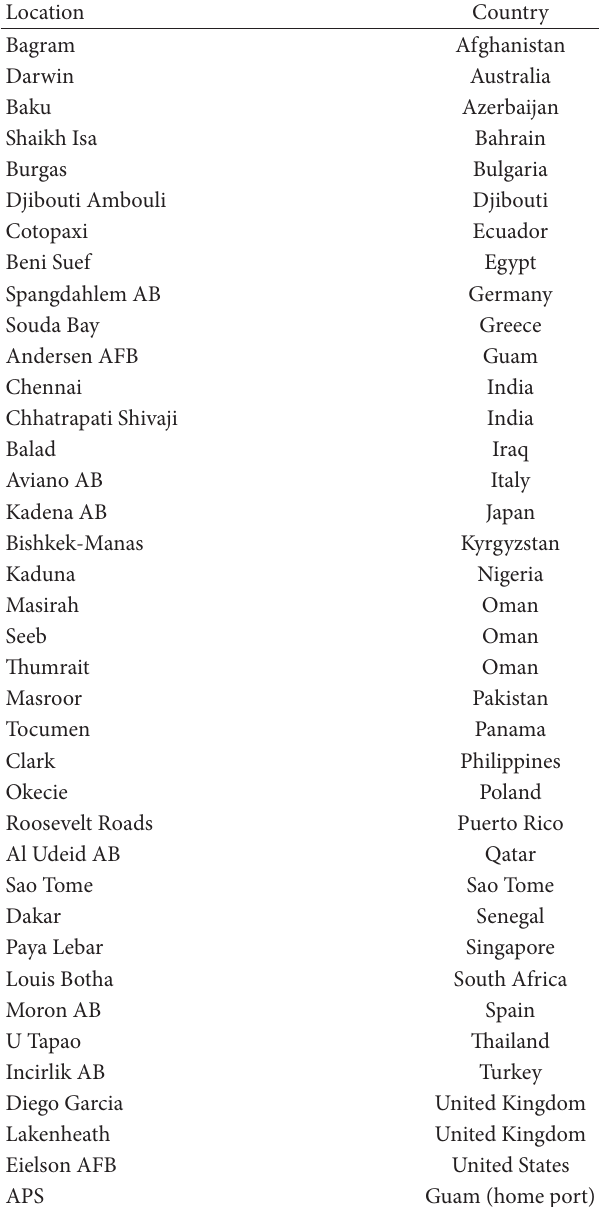
Table 1: Potential